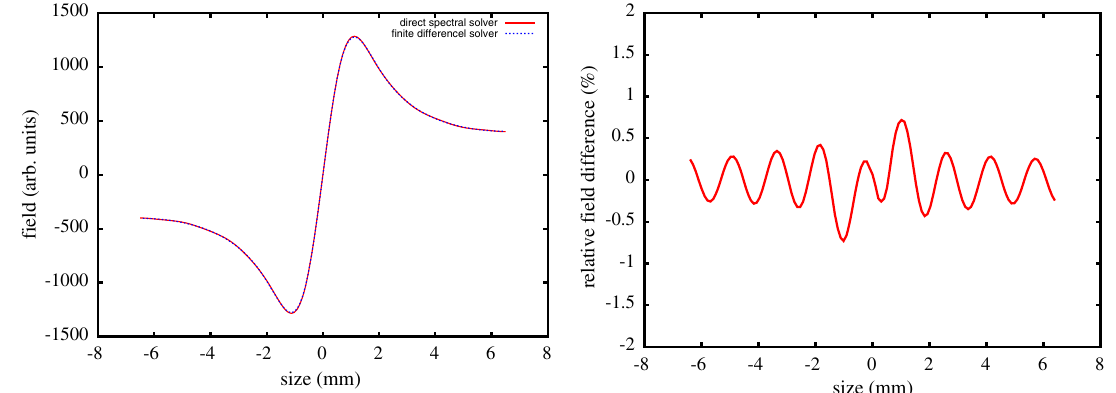
FIG. 2. Electric field on x axis from the above direct spectral solver (red) and from the 2nd order finite difference solver (green) (left), and the normalized relative field difference